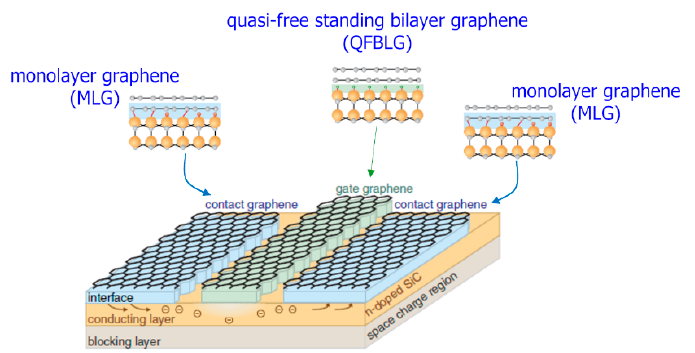
Figure 13. Schematic view of graphene/4H-SiC-based transistor, with two different interfaces, i.e., MLG and QFBLG contact acting as ohmic and Schottky gate contacts, respectively. Figure adapted with permission from Ref. [94]). Copyright 2012 Nature Portfolio.